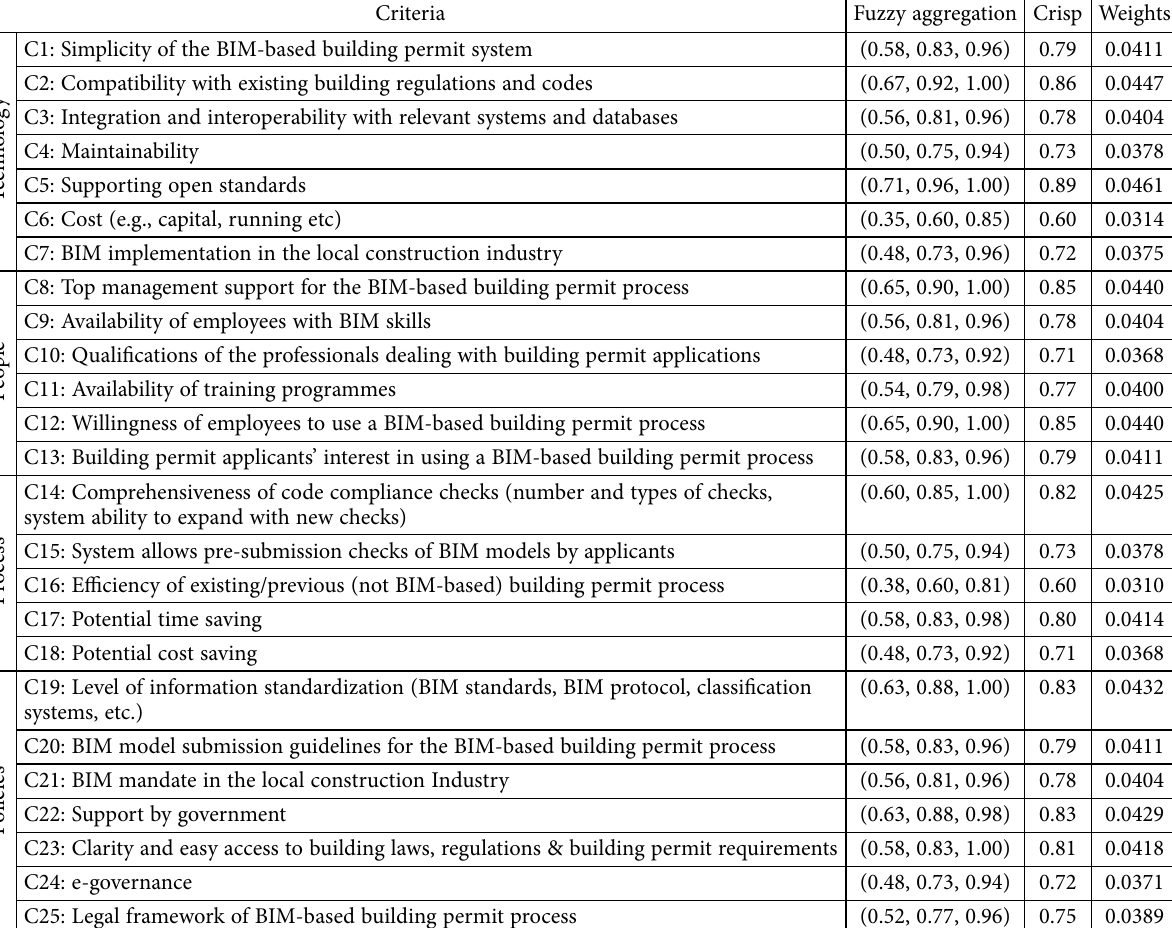
Table 5. Criteria weights from experts’ opinion Criteria Fuzzy aggregation Crisp